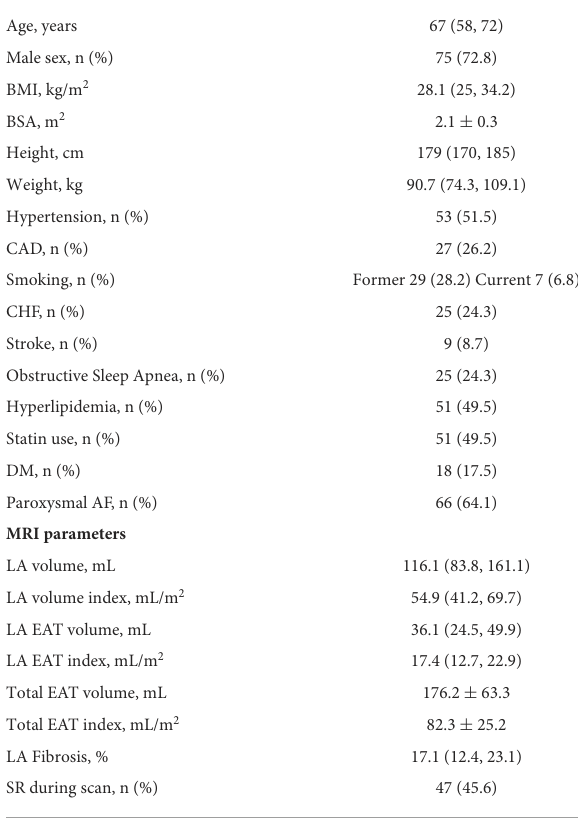
TABLE 1 Baseline characteristics of the 103-patient study